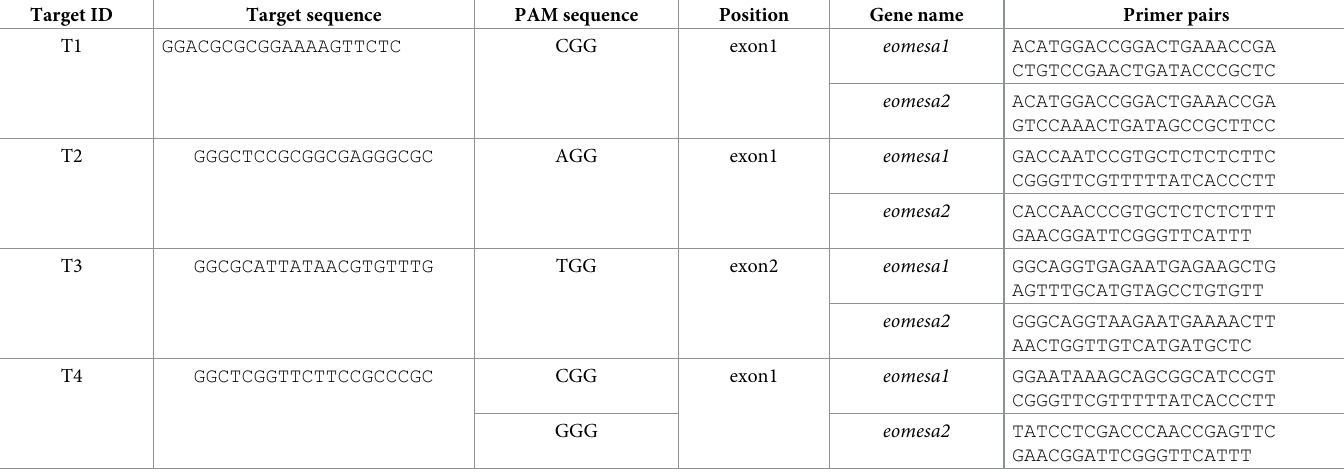
Table 1. The information of target sites and primer pairs for amplifying specific target sites. Target